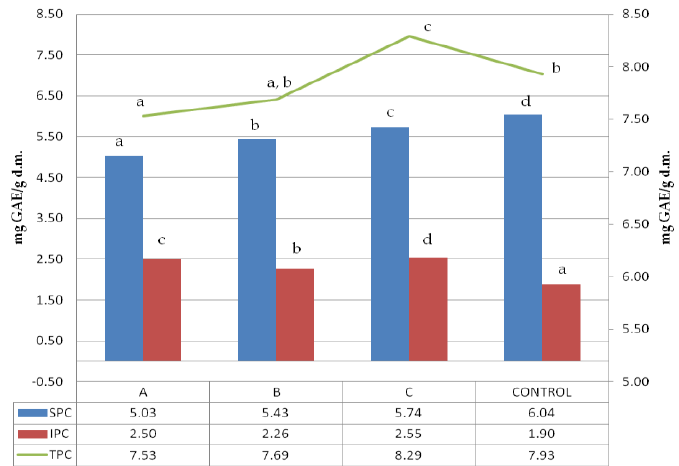
Figure 1. Soluble, insoluble and total polyphenols content. 1:2.5, 1:5, 1:10-solid:liquid ratio of buckwheat grain samples ultrasound treated in water; control–sample of untreated buckwheat grain. Lower-case letters mean values significantly different at p ≤ 0.05 in the particular data series (SPC, IPC, TPC). SPC-soluble polyphenols content, IPC-insoluble polyphenols content, TPC-total polyphenols content.